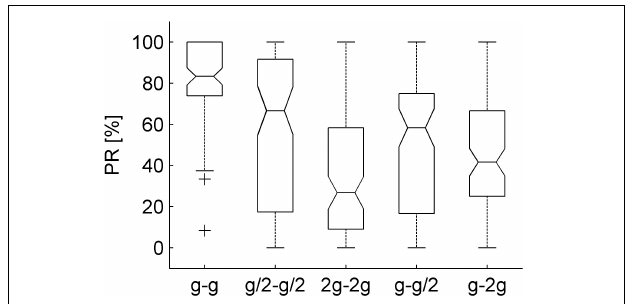
FIGURE 5 | Perception rates of natural motion plotted separately for each gravity condition (three traveled distances × two visual conditions × 16 subjects, n = 96). The bottom and top of the box-and-whisker plots boxes correspond to the lower and upper quartile, respectively. The notch displays the 95% confidence interval of the median. The whiskers extend to the lowest and highest data points, without considering the outlier